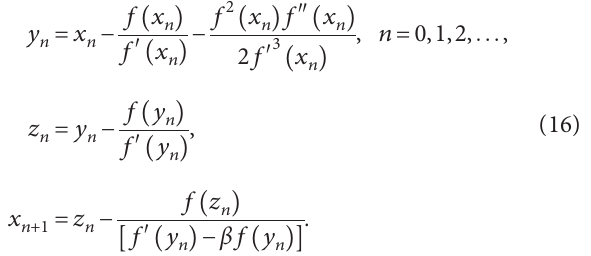
, compute the approximate 0